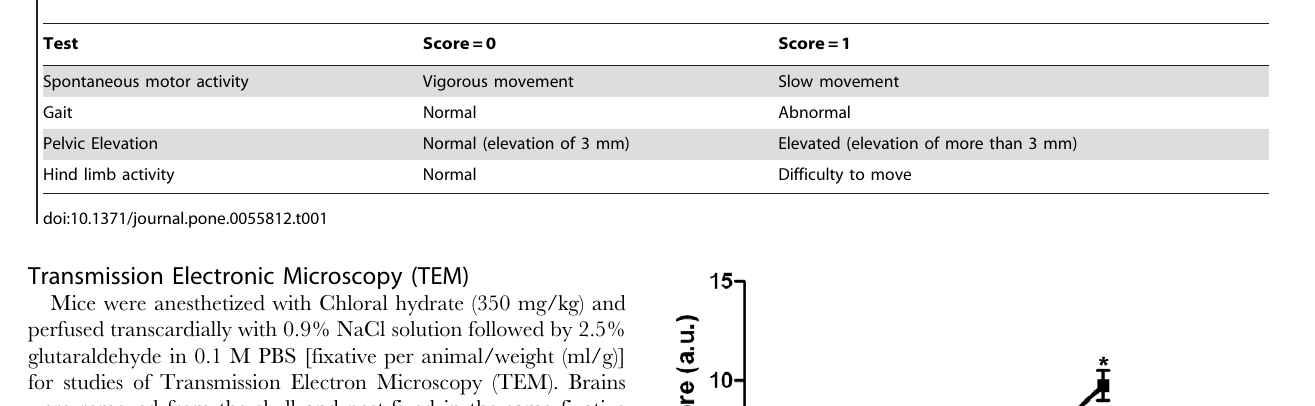
Table 1. Behavioral motor tests.